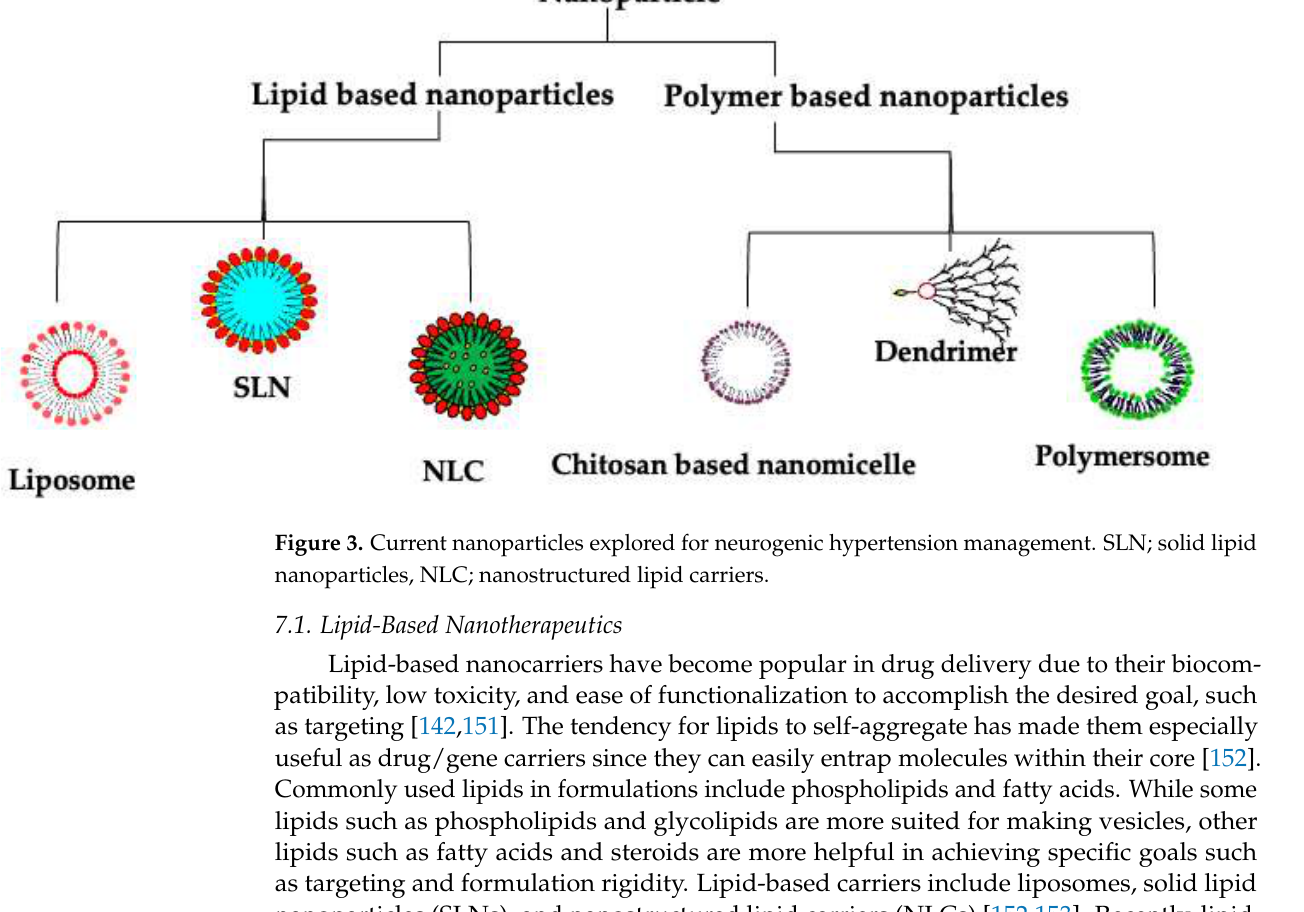
Figure 3. Current nanoparticles explored for neurogenic hypertension management. SLN; solid li- pid nanoparticles, NLC; nanostructured lipid carriers.